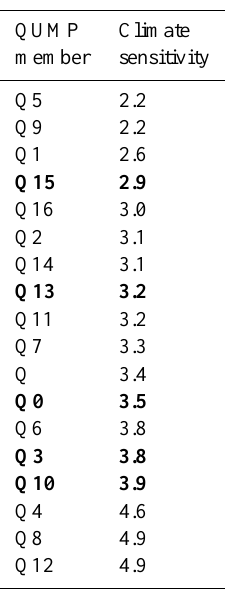
Table 3. Quantifying Uncertainty in Model Predictions (QUMP) members listed in order of climate sensitivity under a doubling of CO 2 concentrations (from Collins et al., 2006). Bold members in- dicate those selected for use in the study. QUMP Climate